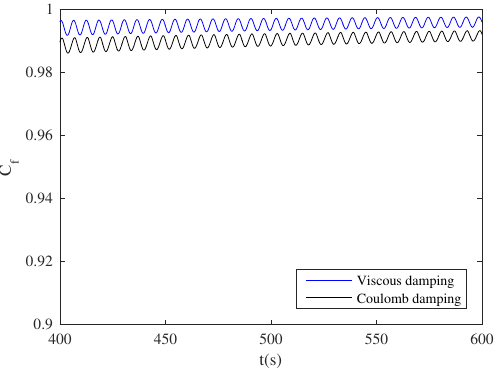
Figure 12. C f variation between the linear (viscous) and coulomb damping models (blue line: C f for linear (viscous) damping; black line: C f for Coulomb damping).